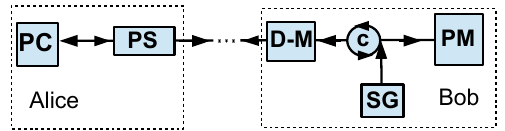
Figure 2. Basic setup of autocompensating high-dimensional cryptography by phase conjugation.